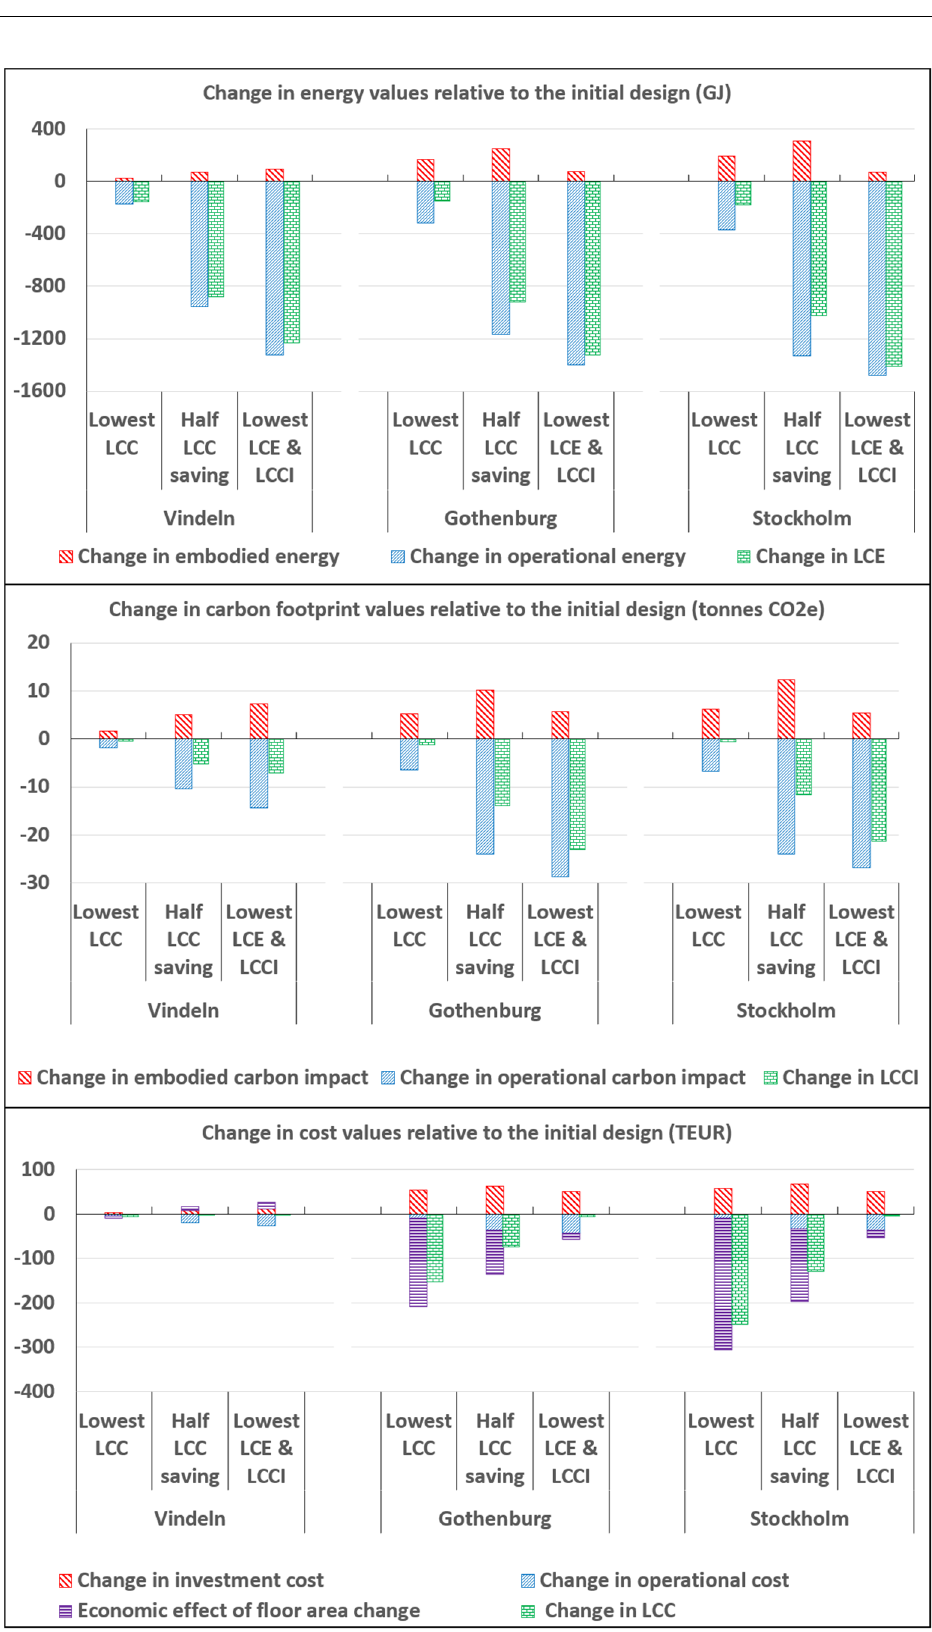
Figure 8. The changes in life cycle energy, carbon impact, and cost values for desirable Pareto solutions listed in Table 7 relative to the initial design. Minus signs indicate savings or reductions while plus signs indicate increase in energy use, carbon impact, and cost relative to the initial design’s performance in different locations. A colour print is recommended.